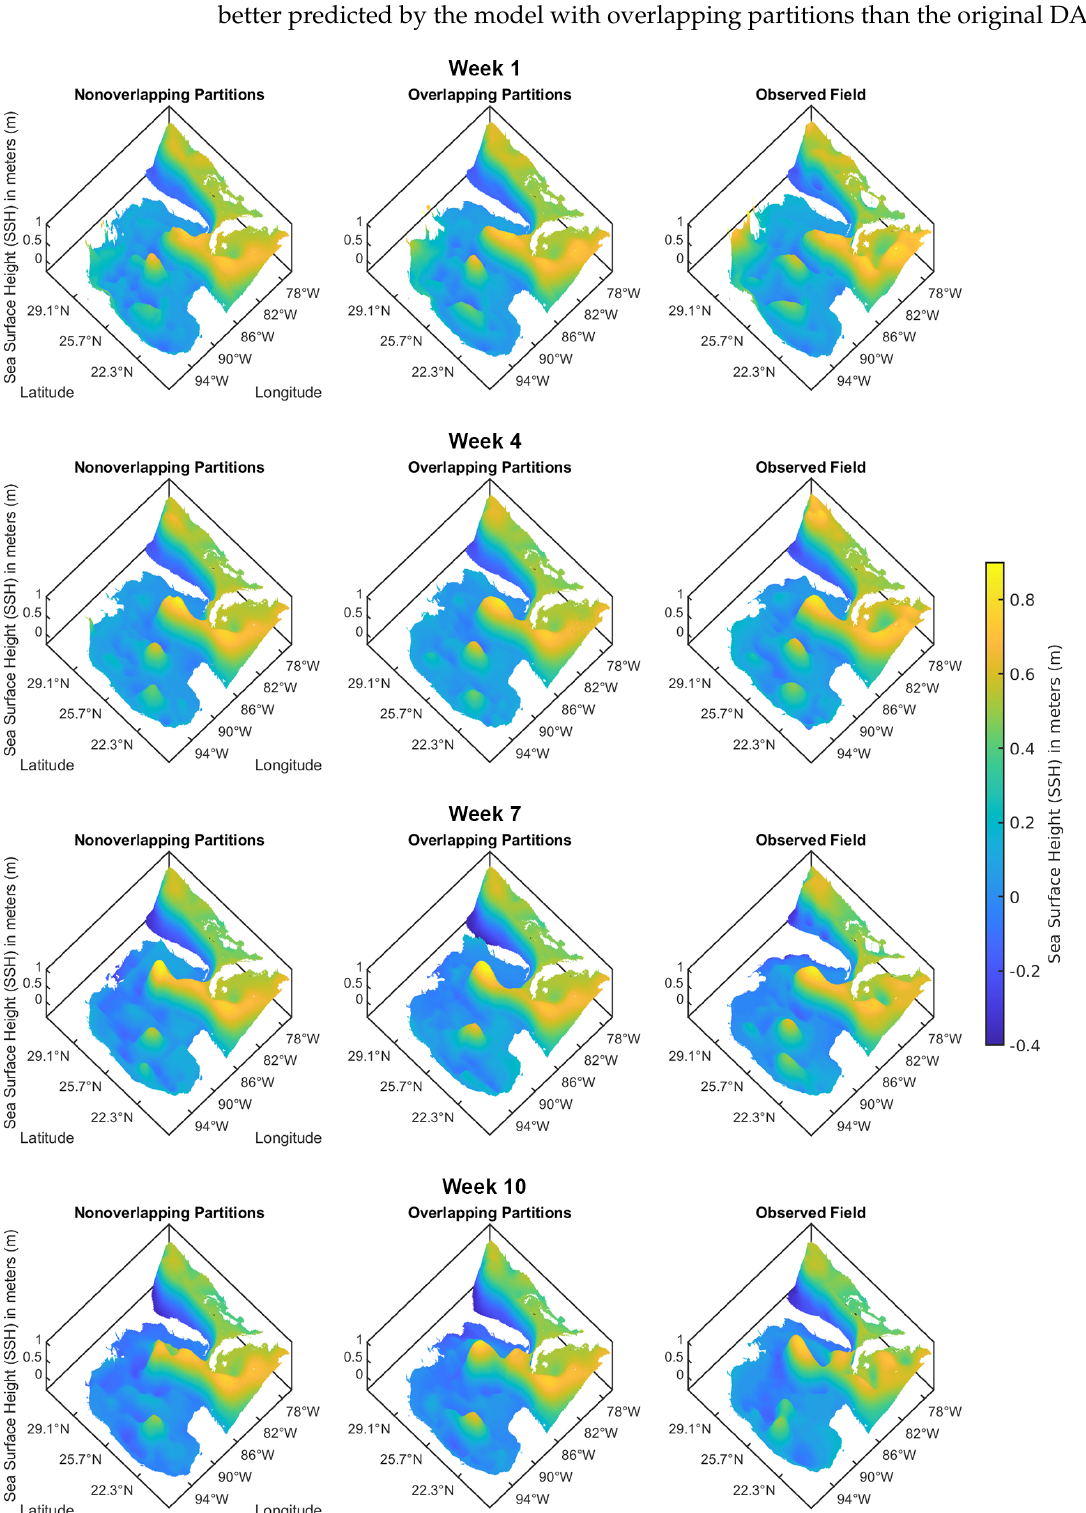
Figure 6. SSH weekly snapshots in meters of a 10-week prediction of the LC system SSH spanning March to May of 2008. Predicted SSH on Week 1, 4, 7, and 10 are shown for the model with no overlapping boundaries (left column), with overlapping boundaries (center column), and the observed (HYCOM) SSH is shown for the same weeks in the right